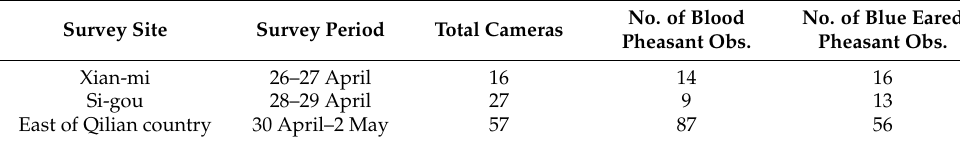
Table A2. Result of line transect and camera-trap survey.